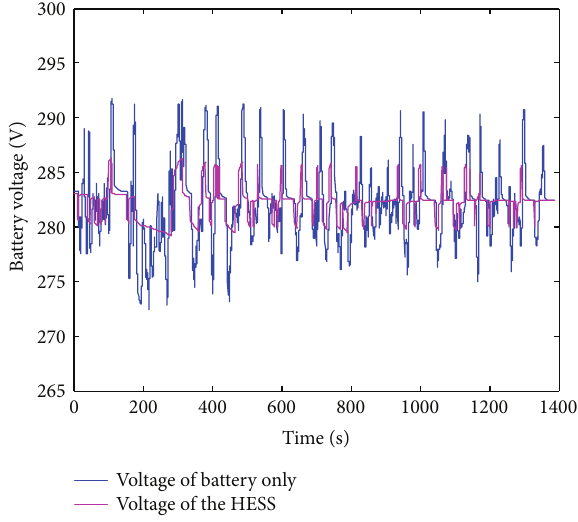
Figure 17: Comparison of the battery voltage curves.